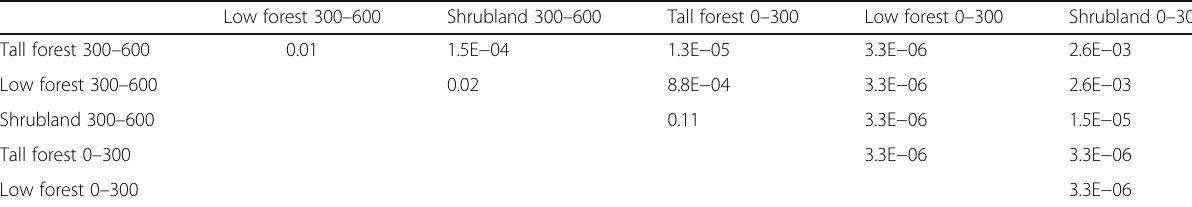
Table 5 Probability ( p value) of the multiple median comparison tests, for the 10 and 15 largest individuals within each cover type-distance